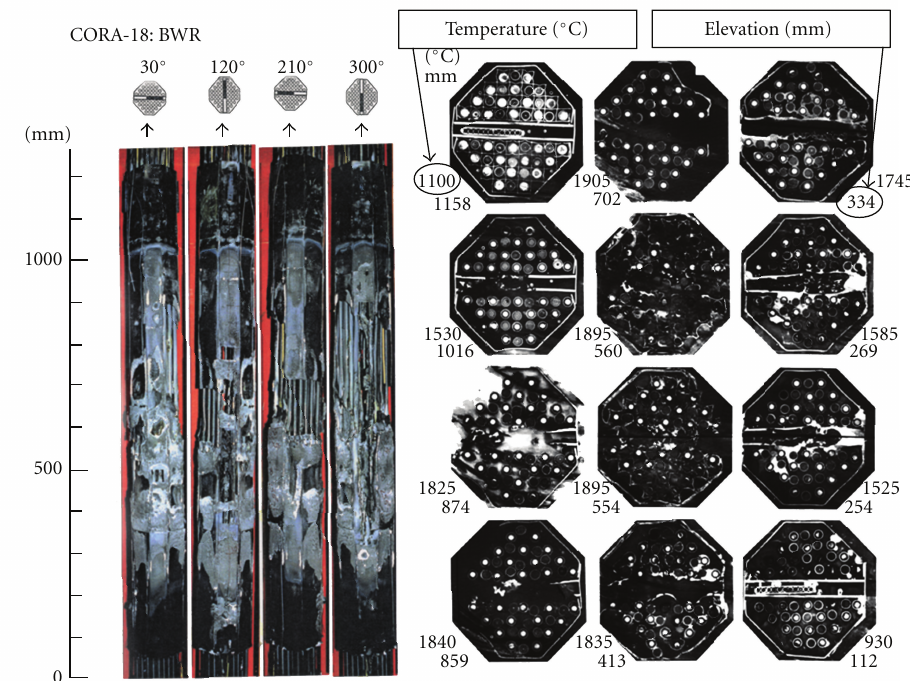
Figure 1: Posttest vertical view and horizontal metallographic cross-sections for